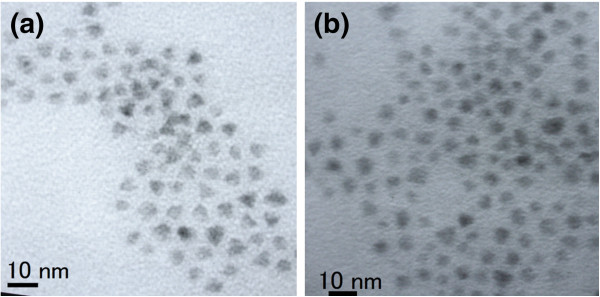
TEM images CdTe0.5Se0.5/Cd0.5Zn0.5S core/shell QDs shown in Table4. (a) Sample 6–5 and (b) sample 6–9. The core/shell QDs were prepared by using sample 6.